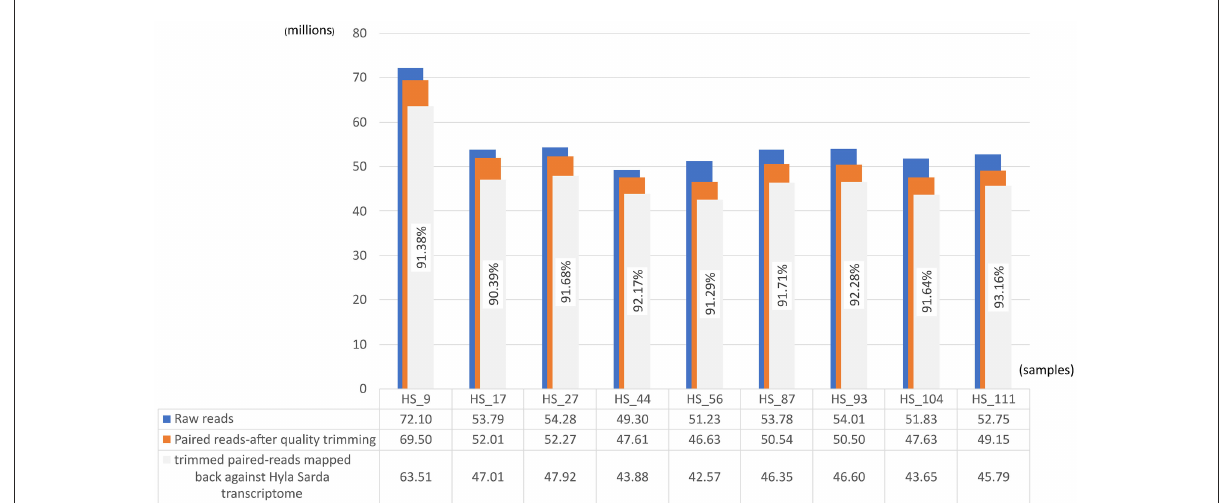
FIGURE1 Paired-reads mapped back against the Hyla sarda de novo transcriptome. For each sample, we have in blue, the representation of total paired-reads, in orange, the total paired-reads after the adapter removal and quality trimming, and in gray we have the trimmed paired-reads mapped back against the Hyla sarda assembled de novo